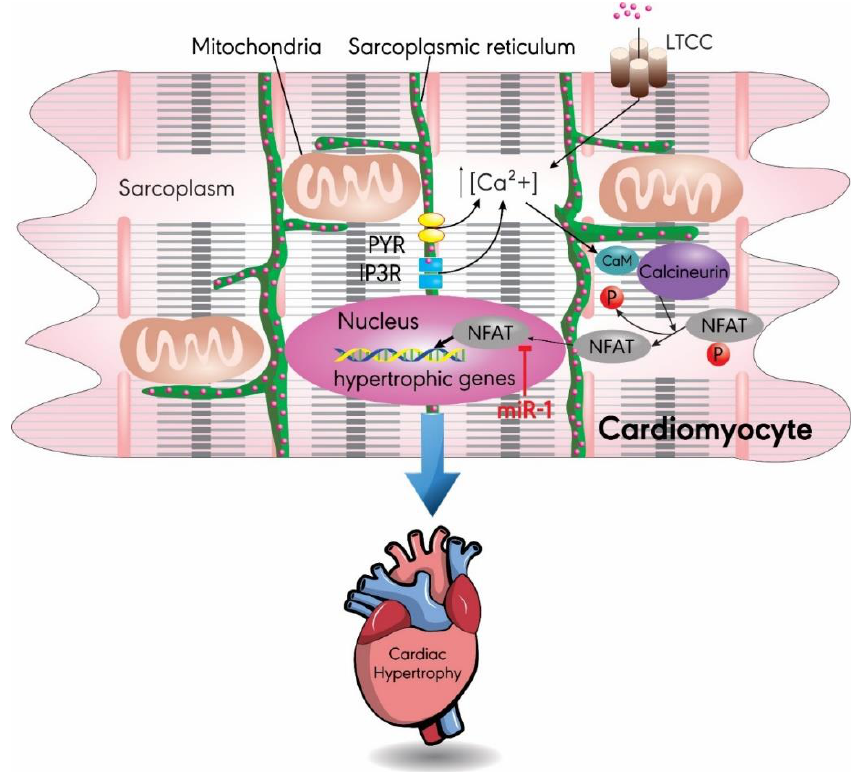
Figure 2. MiR-1 targets the calcineurin – NFAT signaling pathway; miR-1 plays a protective role in cardiac hypertrophy by decreasing the expression of NFAT. An increase in intracellular calcium ion levels activates the CaM – calcineurin complex, which dephosphorylates NFAT, leading to its translocation into the nucleus. In the nucleus, expression of NFAT increases the transcription of hypertrophic genes, resulting in cardiac hypertrophy. CaM: calmodulin; IP3R: inositol 1,4,5-triphosphate receptor; LTCC: L-type calcium channel; RYR: ryanodine receptor; SR: sarcoplasmic reticulum .